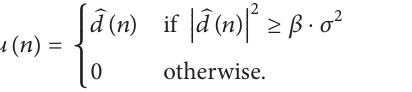
multiplied with Channel Transfer Function of branch 𝑖 ( 𝐻 𝑖 , 𝑖 = 1 to 4) and is IFFTed. If the output of IFFT has a large